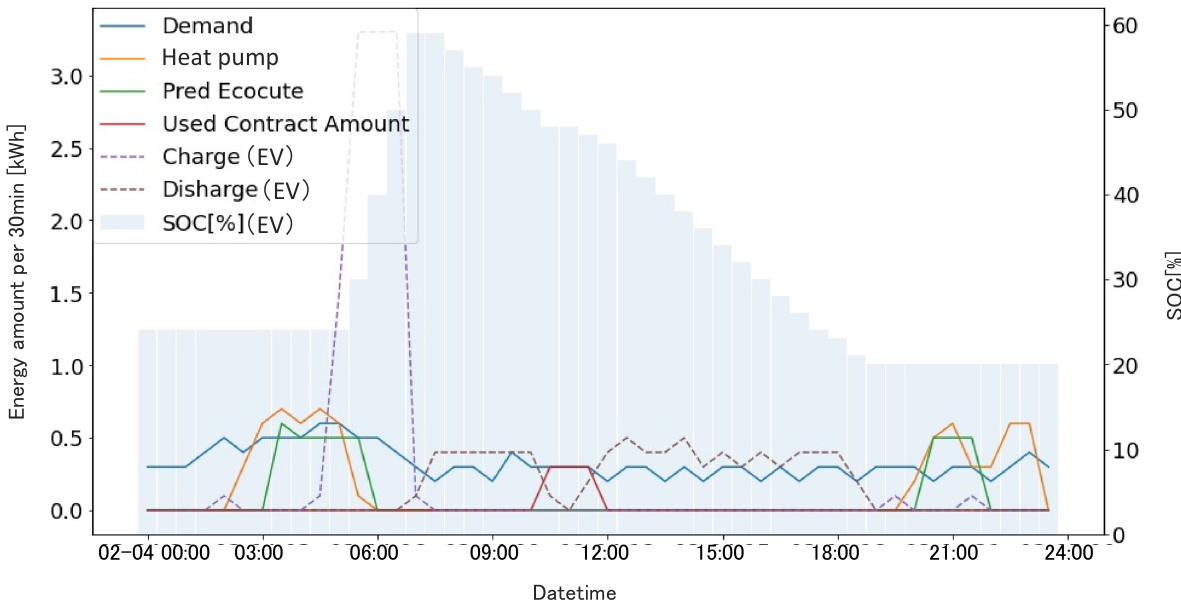
Figure 6. Electricity usage of HOME1 on one day during Phase 2 of the experiment.